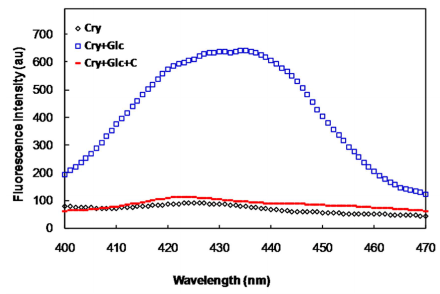
Figure 1. Non-tryptophan AGE fluorescence of α -crystallin (Cry), in the presence of 500 mM of glucose (Glc) with and without crocin(s)